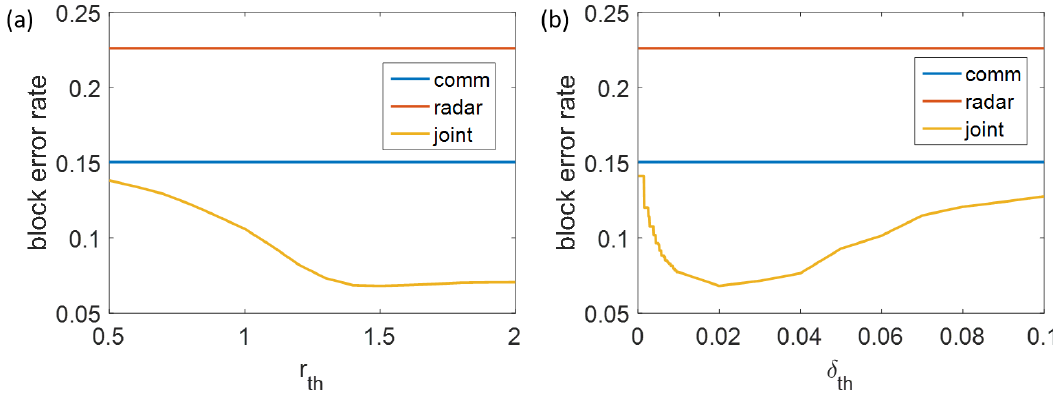
Figure 4. Accuracy comparison of the joint diagnosis algorithm and the single algorithm based on communication signals or sensing echoes: ( a ) with the scan of r th ; and ( b ) with the scan of δ th .